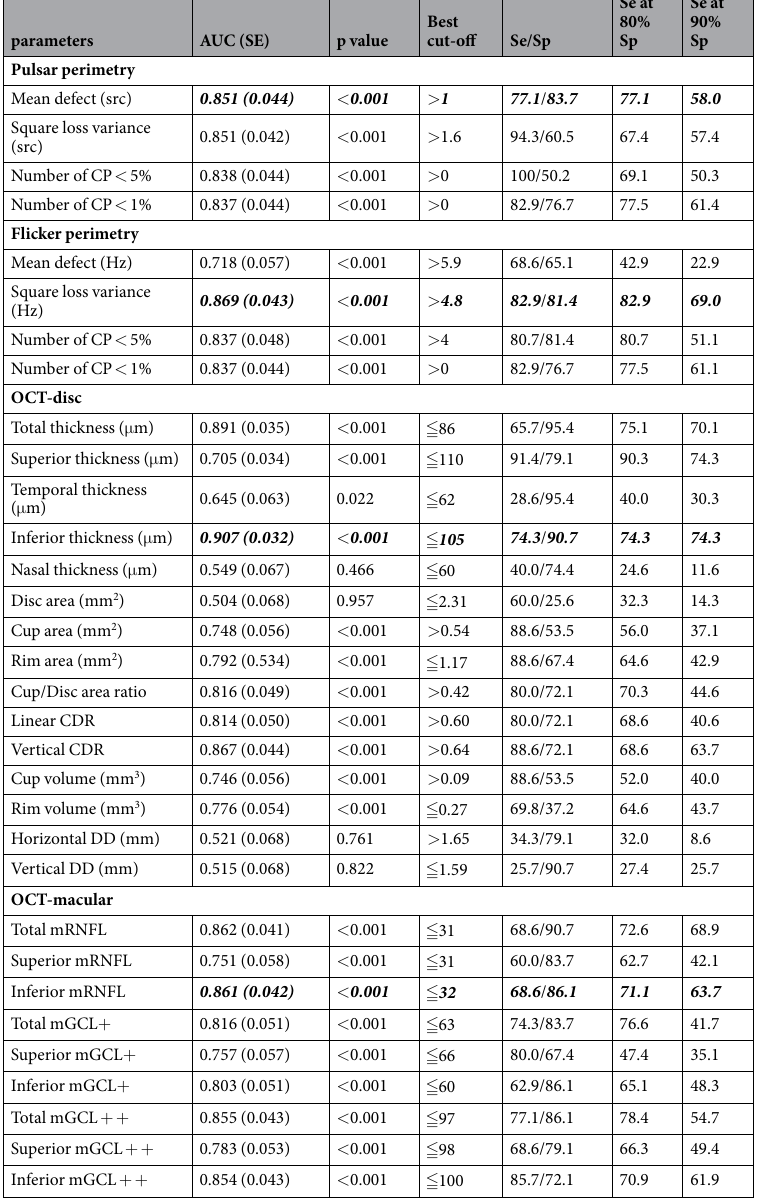
Table 4. Results of receiver operating characteristic analysis between control and early glaucoma eyes. PPG = pre-perimetric glaucoma; EG = early glaucoma; CP = corrected probability; OCT = optical coherence tomography; CDR = cup to disc ratio; DD = disc diameter; mRNFL = macular retinal nerve fiber